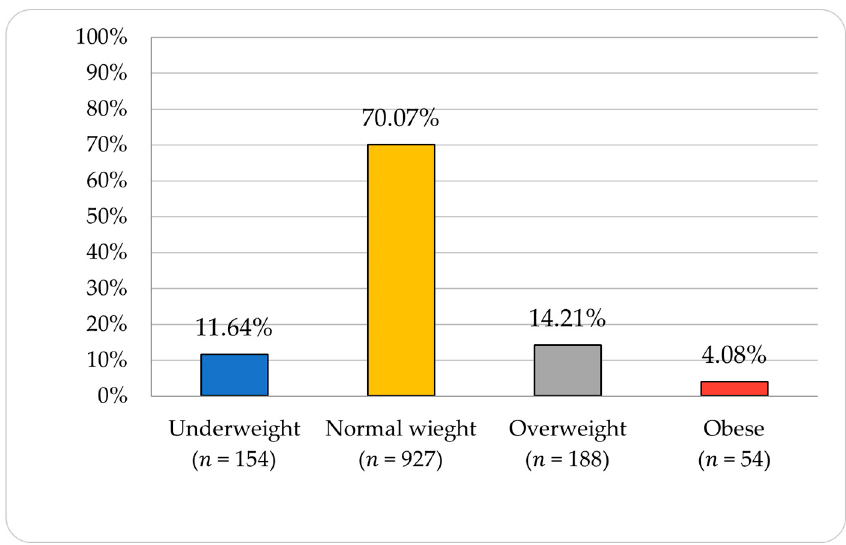
Figure 2. Weight distribution based on BMI (Body Mass Index).